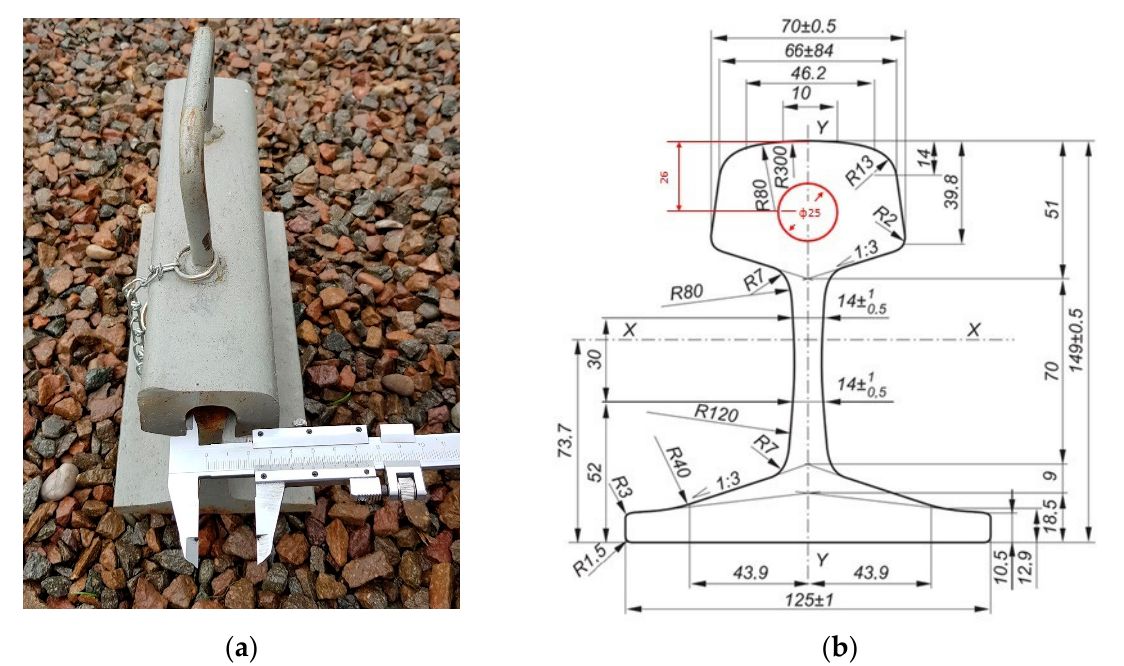
Figure 2. Measuring hole diameter inside the crown of the rail type S49 (49E1) (own photograph): ( a ) overhead view; ( b ) cross section.